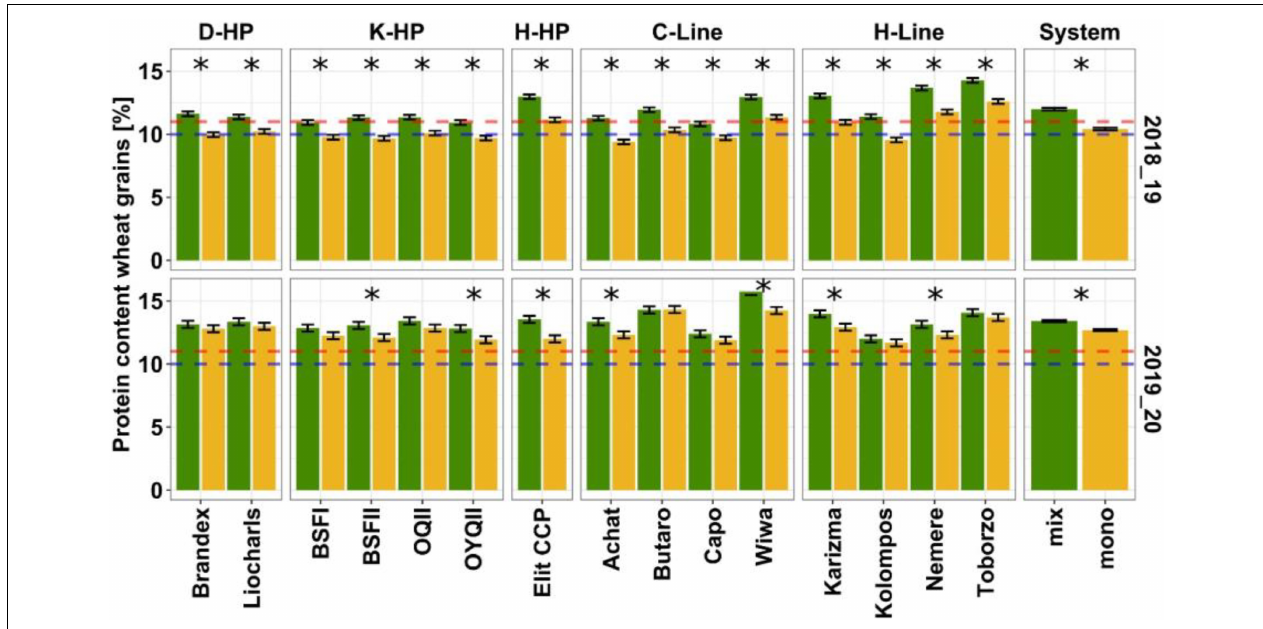
FIGURE 5 | Wheat grain protein content (%) in the mixtures (green) and monoculture (yellow). Estimated marginal means and standard error for from linear mixed effect models are plotted. Asterisks show significant differences at P < 0.05 estimated from mixed models with pairwise comparison and Holm correction between the mixtures and monocultures in wheat entries. Dashed lines indicate quality thresholds for protein given by Drangmeister (2011). Red dashed line marks 10% and the blue dashed line 11% protein content. Quality classes are as follows: fodder wheat < 10%, baking wheat = 10–11%, and high-quality baking wheat >